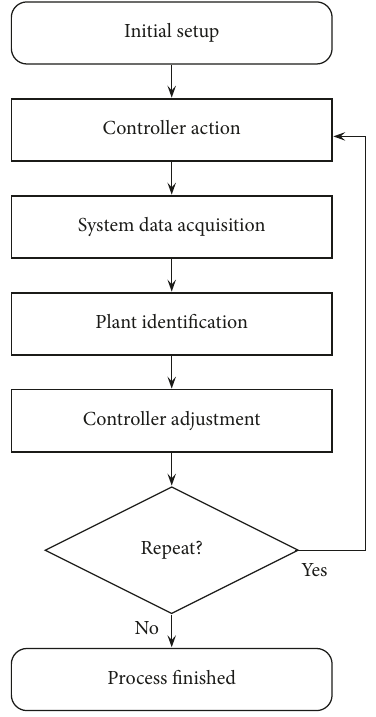
Figure 2: Algorithm for the process of adaptive control.